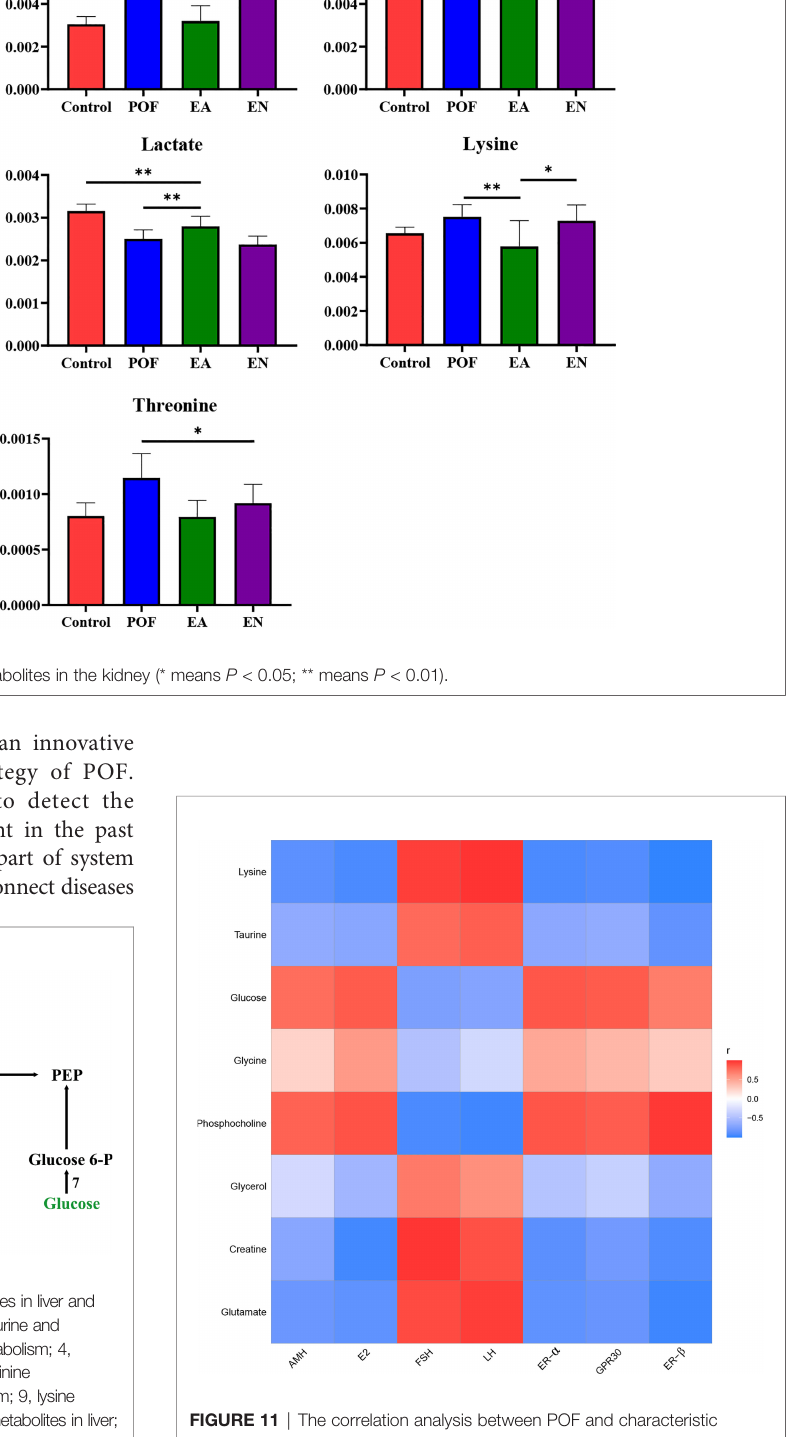
FIGURE 11 | The correlation analysis between POF and characteristic metabolites in the liver.